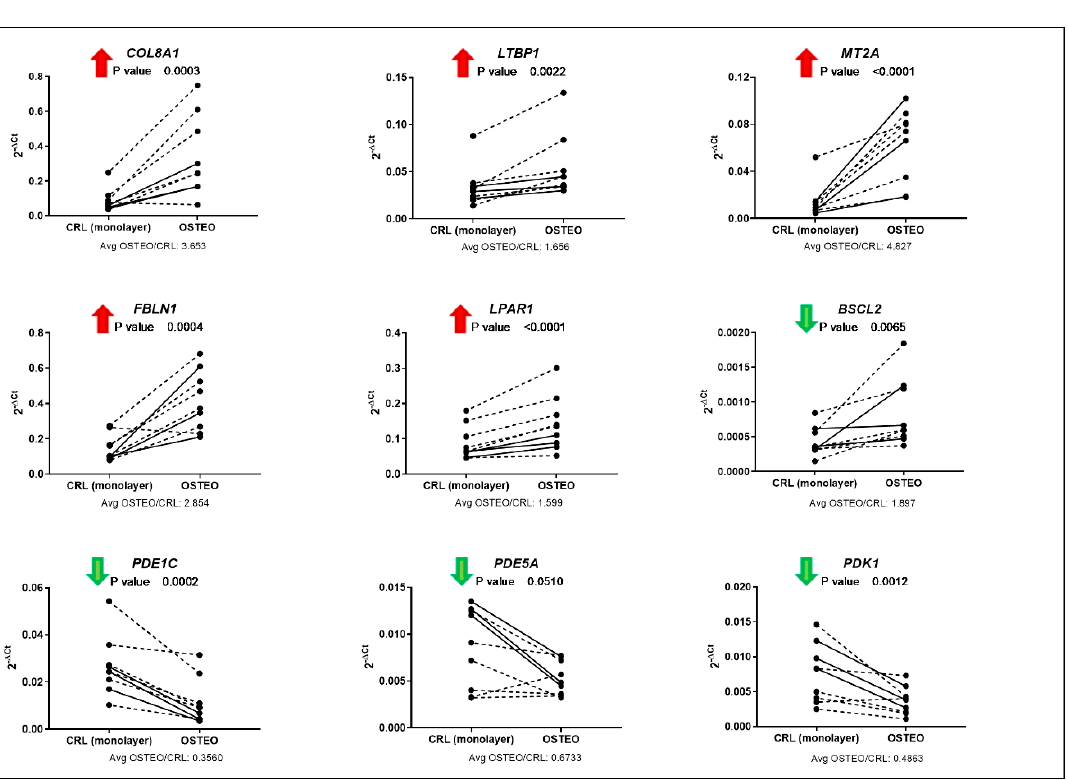
Figure 3. qPCR validation of linear targets corresponding to differentially expressed circular RNAs in osteogenic differentiation, as identified by microarray analysis. Full lines represent results from the same donors used for microarray, while dashed lines correspond to additional donors tested. For each gene of interest (GOI), the results are shown as 2 - Δ Ct , where Δ Ct is calculated as the difference between GOI and reference gene ( RPLP0 ) Ct values. The p -value and the average fold change between day 7 osteogenic differentiation and day 7 control (monolayer) are reported for each gene. The arrow next to the gene symbol indicates if the corresponding circRNA resulted as up- or downregulated from the microarray analysis.